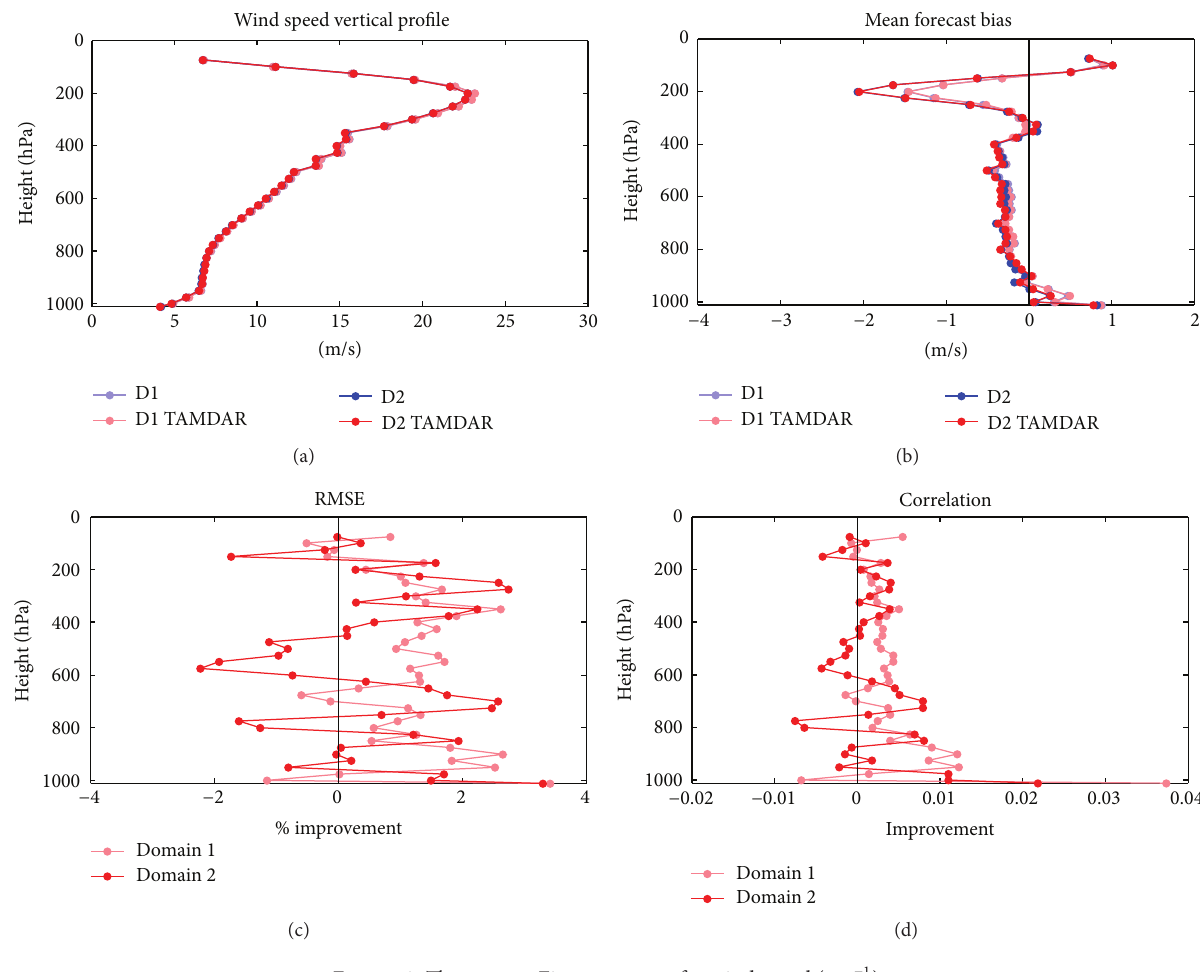
Figure 9: The same as Figure 5 except for wind speed (ms −1